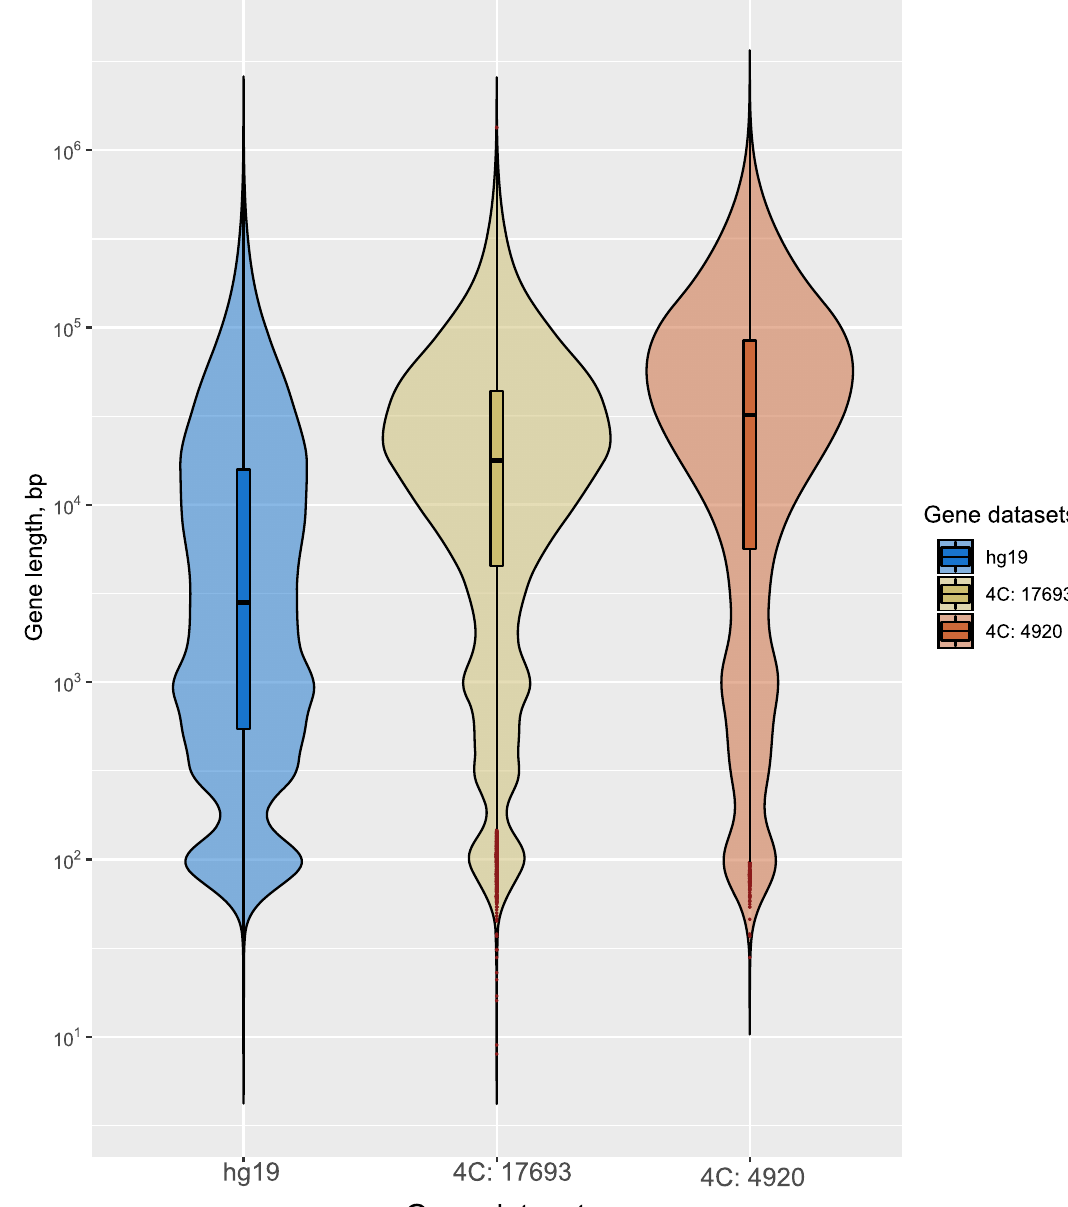
Figure 7. The violin plots for gene length in the genome (hg19), all rDNA-contacting genes (17,693 genes), and the selected 4920 genes. The details are described in the Supplementary